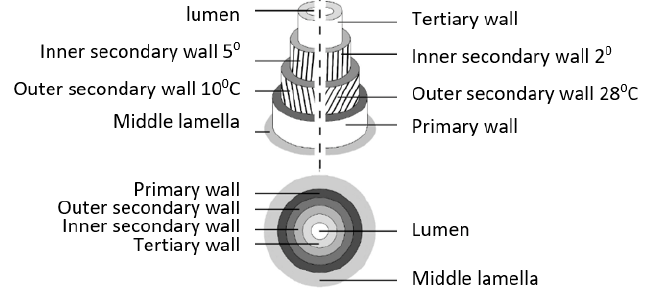
Figure 6. Structure of the elementary hemp fibre. a) Longitudinal section; b) Cross-section of fibre [28].